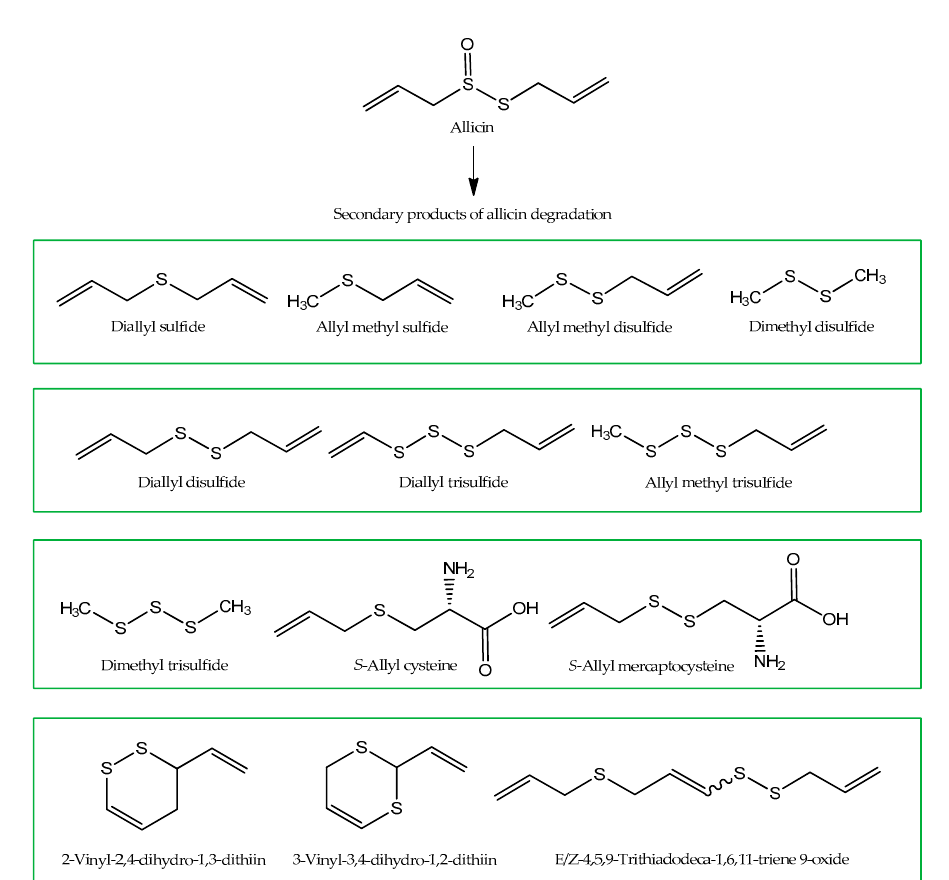
Figure 3. Chemical structures of the main by-products of the degradation of allicin present in gar-